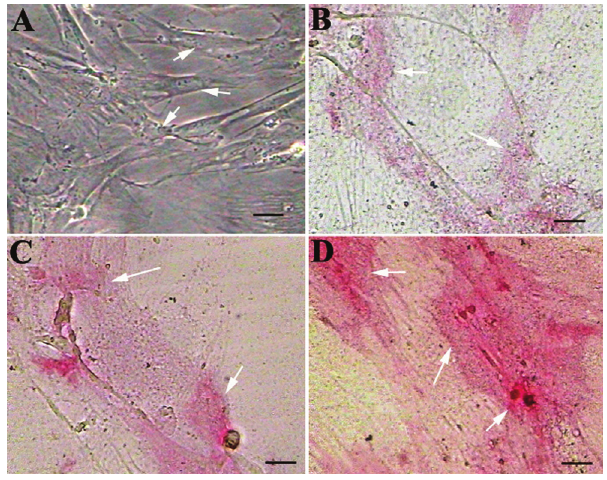
Figure 2 - CQ enhances differentiation of bone marrow mesenchymal stem cells (MSCs) into osteoblasts: MSCs were grown in basal media and supplemented with 100, 200 or 300 µg/mL CQ plant extract (B, C and D, respectively) and stained for alkaline phosphatase (ALP). Note that MSCs grown in the control media are negative for ALP (A), cells grown in the basal media supplemented with 100, 200 µg/mL CQ (B,C) are weakly posi- tive for ALP, and cells supplemented with 300 µg/mL CQ (D) are strongly positive for ALP, suggesting differentiation into osteoblasts. Arrows indicate undifferentiated MSCs in A and differentiating MSCs in B, C and D. Scale bar=25 µm.